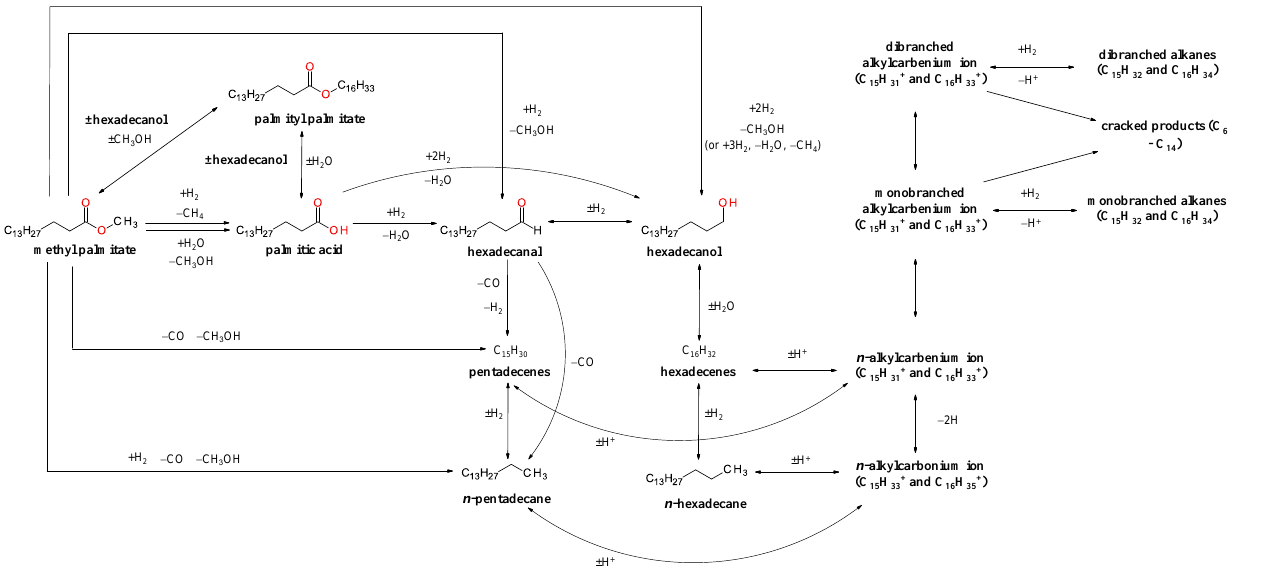
Scheme 1. Methyl palmitate HDO–isomerization.